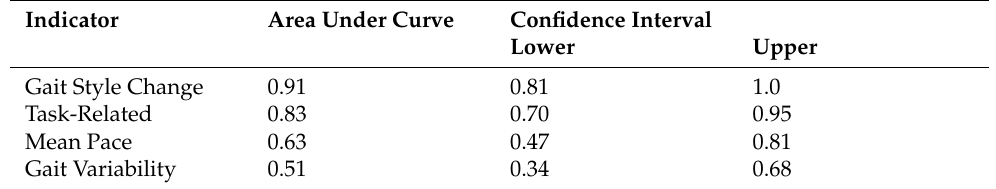
Table 3. Discriminative accuracy of each group of gait parameters